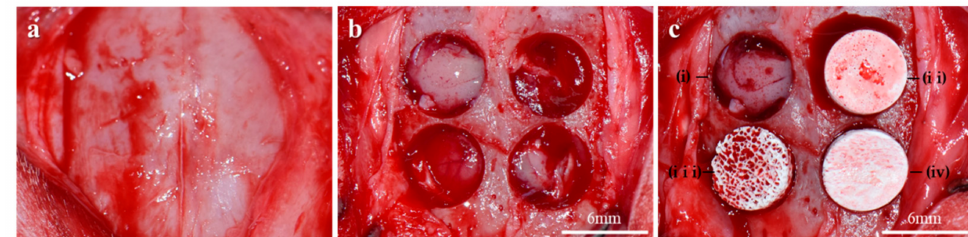
Figure 12. Surgical procedures using the rabbit calvaria defect model. ( a ) Exposed rabbit calvarium. ( b ) Creation of four circular bony defects. ( c ) Specimen placements in the defects. i: Control, ii: Cortical group, iii: Cancellous group, iv: 2layer